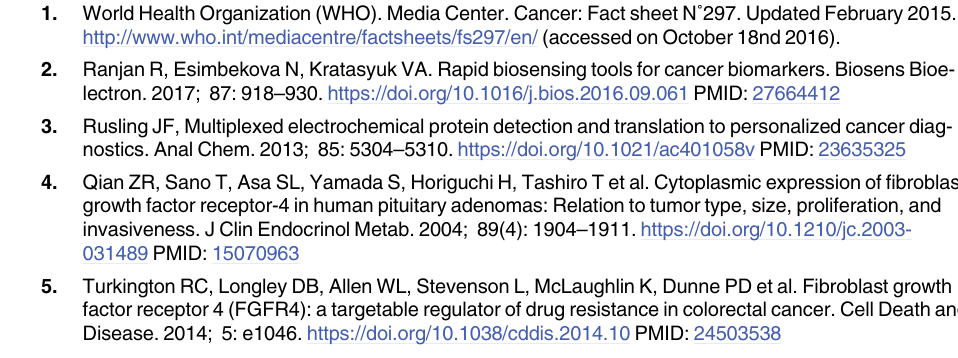
S4 Fig. Calibration plot obtained with the electrochemical immunosensor for samples solutions containing 2.5 μg of raw KM12SM lysate solution supplemented with increasing amounts of the standard FGFR4 solution. Error bars are estimated as a triple that of the stan- dard deviation (n = 3). S5 Fig. Comparison of the results obtained with the developed immunosensor and the ELISA methodologies. Dots in the graph correspond to (from left to right) to lysates from MDA-MB-436, SW620, BxPC3, KM12C, SW480, KM12SM, MCF7 and SKBR3 cells, respectively. Error bars are estimated as a triple that of the standard deviation (n =